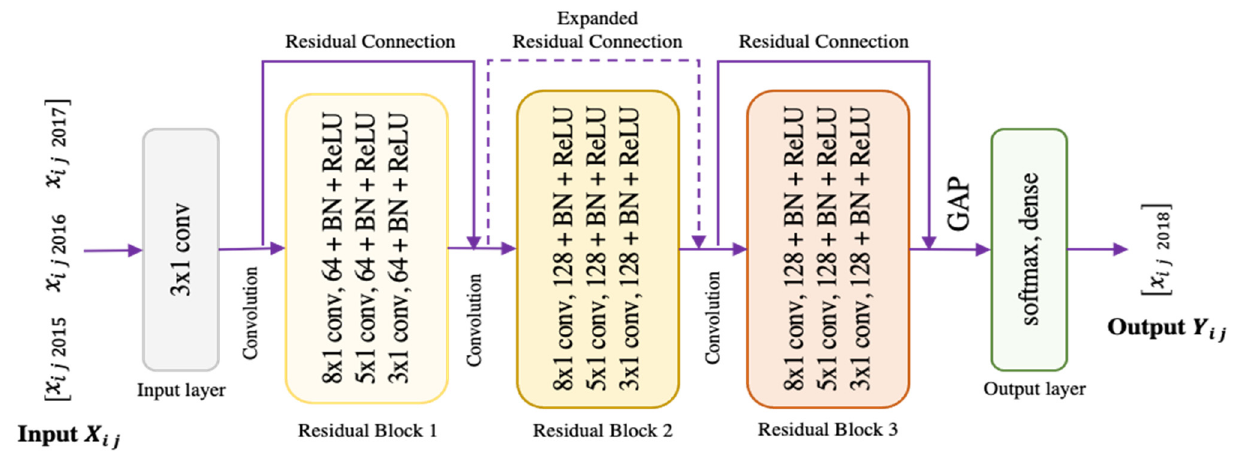
Figure 4. The ResNets model architecture.